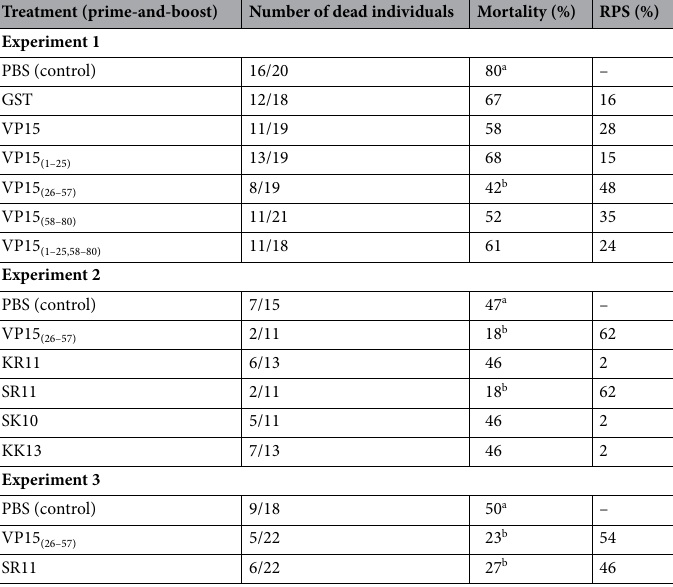
Table 1. Mortality and RPS of VP15, truncated VP15 and SR11. a,b p < 0.05.